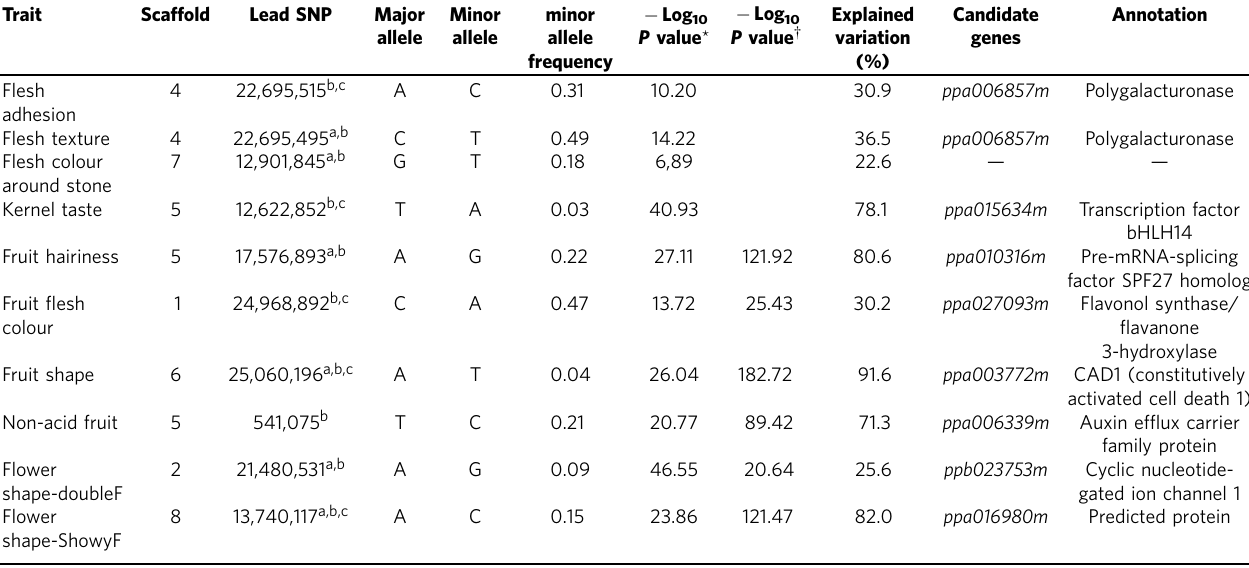
Table 1 | Lead SNPs significantly associated with 10 agronomic traits according to the genome-wide association study performed for the 129 peach accessions and related candidate